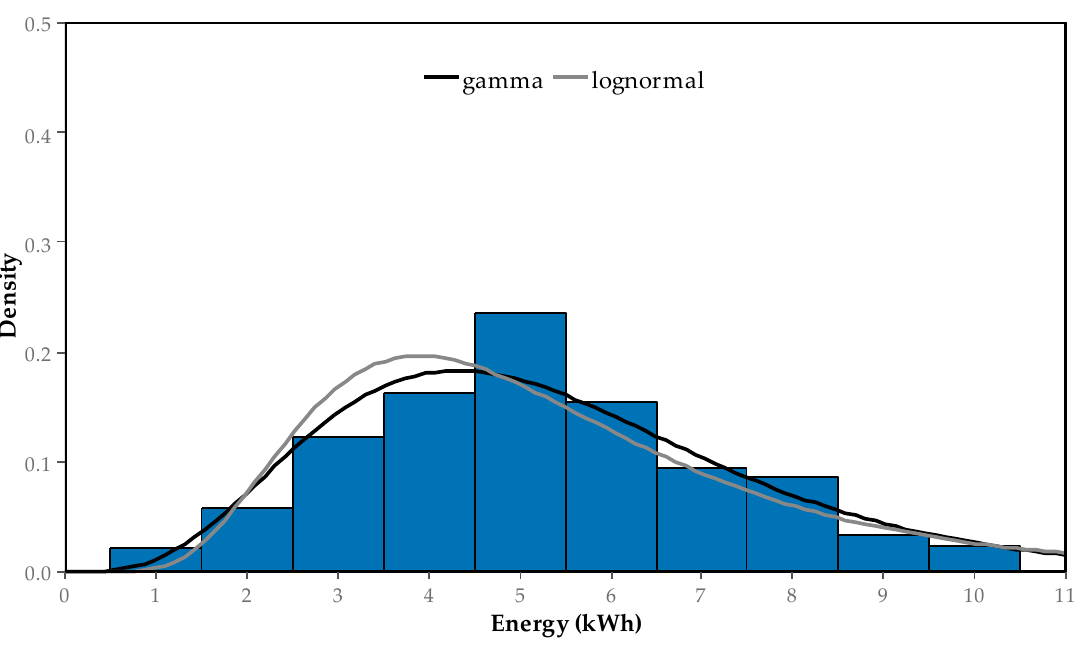
Figure 1. Histogram of the energy per charge and two common parametric distributions that try to explain its behavior.